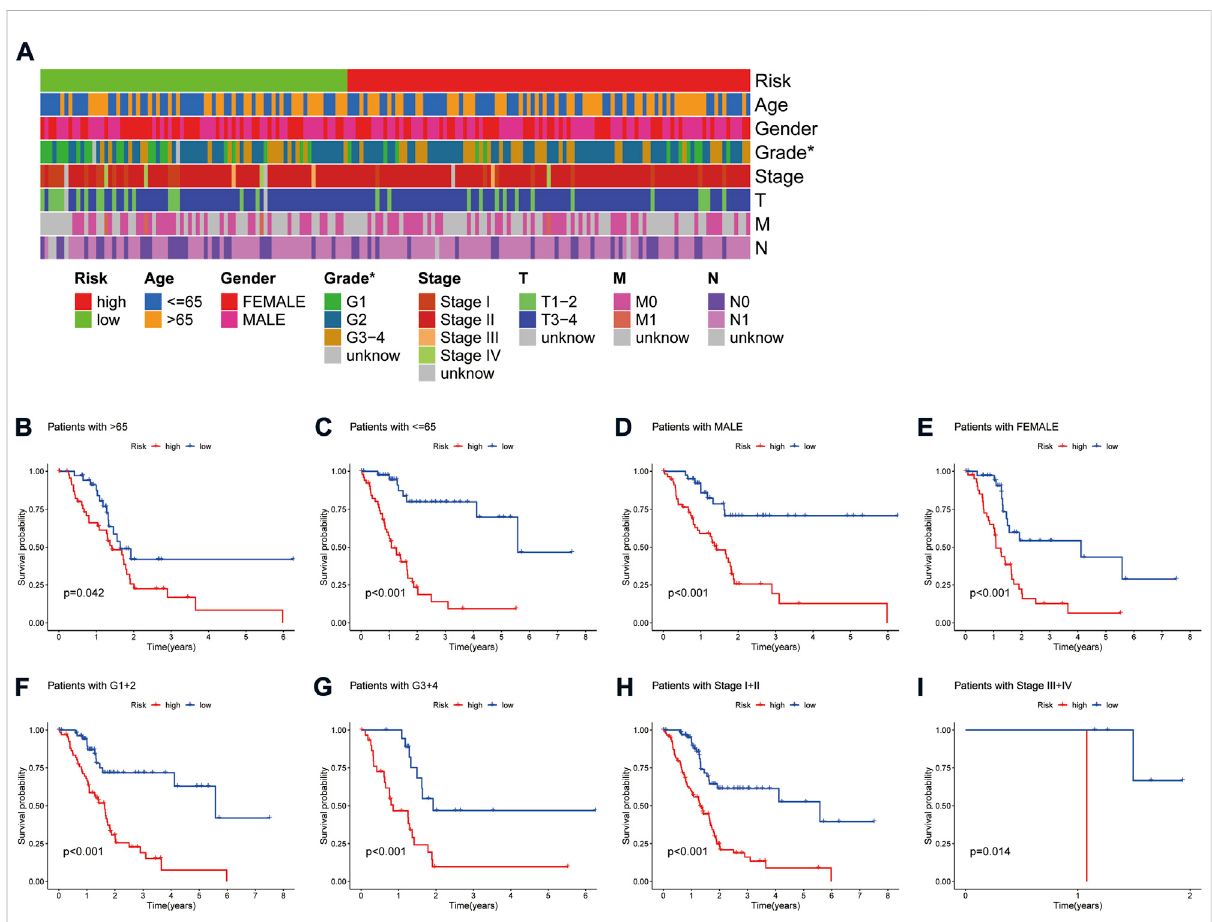
FIGURE 4 Correlationanalysisoftherisksignaturewithclinicopathologicalparameters. (A) Heatmapofthedistributionofclinicopathologicalparameters inthehigh-andlow-riskgroups. (B,C) Kaplan-Meiersurvivalcurves oflow- andhigh-riskgroupssortedbyage. (D,E) Kaplan-Meiersurvivalcurvesof low- and high-risk groups sorted by gender. (F,G) Kaplan-Meier survival curves of low- and high-risk groups sorted by grade. (H,I) Kaplan-Meier survival curves of low- and high-risk groups sorted by TNM